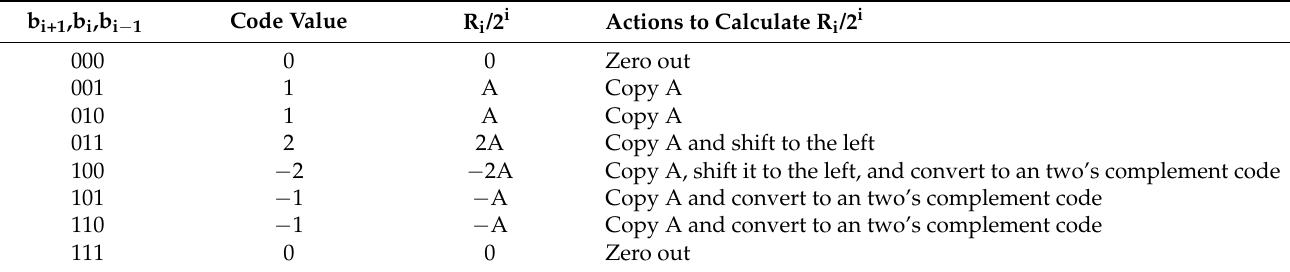
Table 1. Table of operations to form PPs for Booth ’ s algorithm.